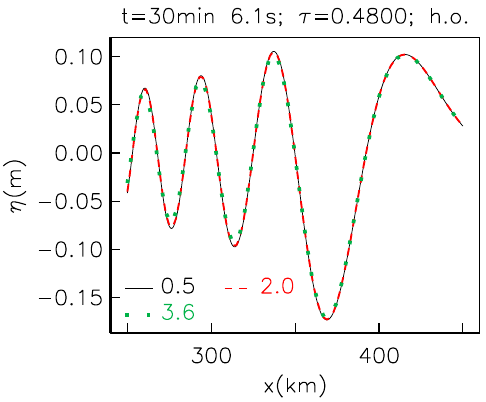
Fig. 3. The surface elevation along the y = 0 transect after 30min. Results for different resolutions (given in km) for the optimized Boussinesq model (h.o.) and initial conditions obtained with the Green function of Kajiura. Waves are propagating to the right.